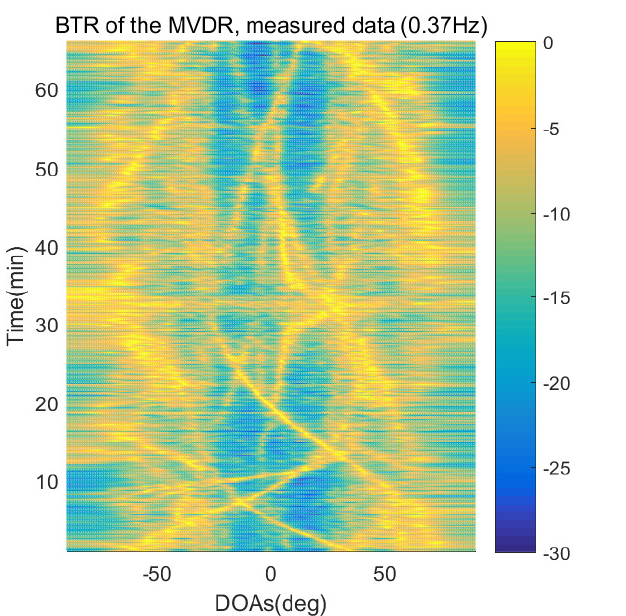
Figure 23. Bearing time records of the MVDR: 66 min, signal frequency = 0.37